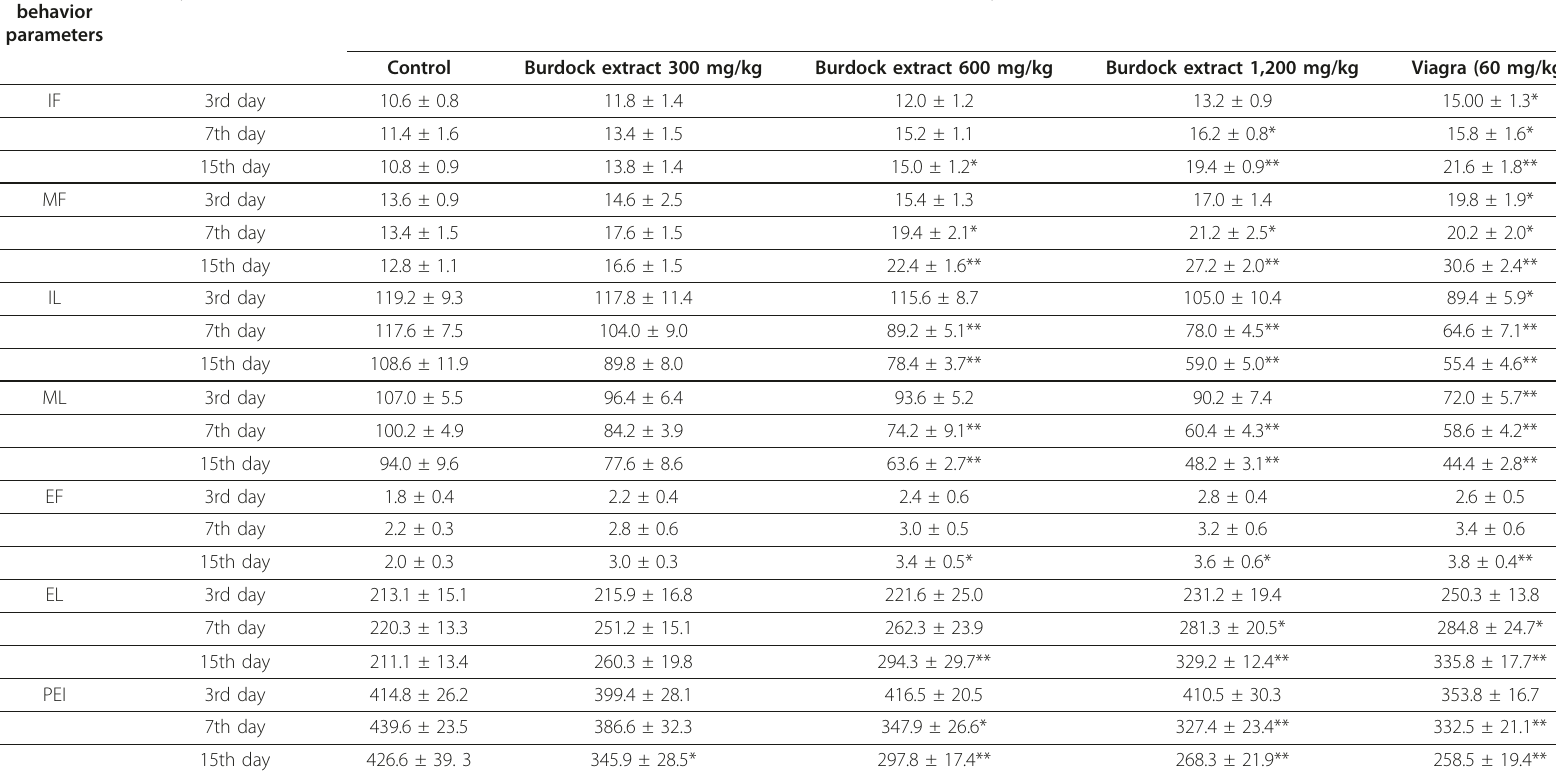
Table 1 Effect of aqueous extract of burdock roots on mating behavior in male rats Sexual- behavior